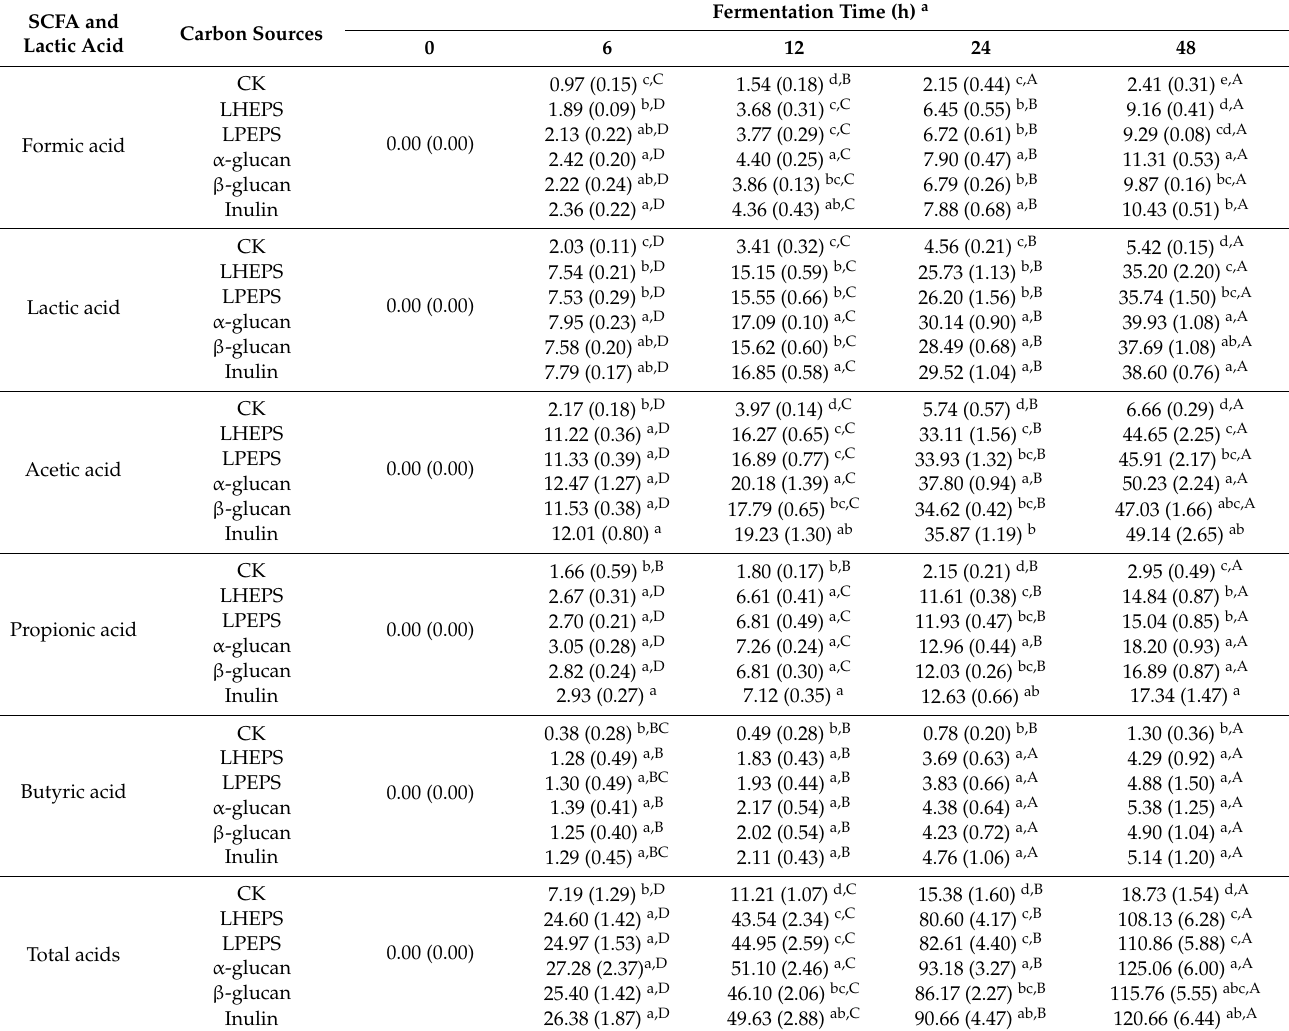
Table 2. Production of different kinds of SCFAs and total SCFAs during in vitro fermentation using different polysaccharides as a substrate, compared with a no treatment control ( n = 3) a